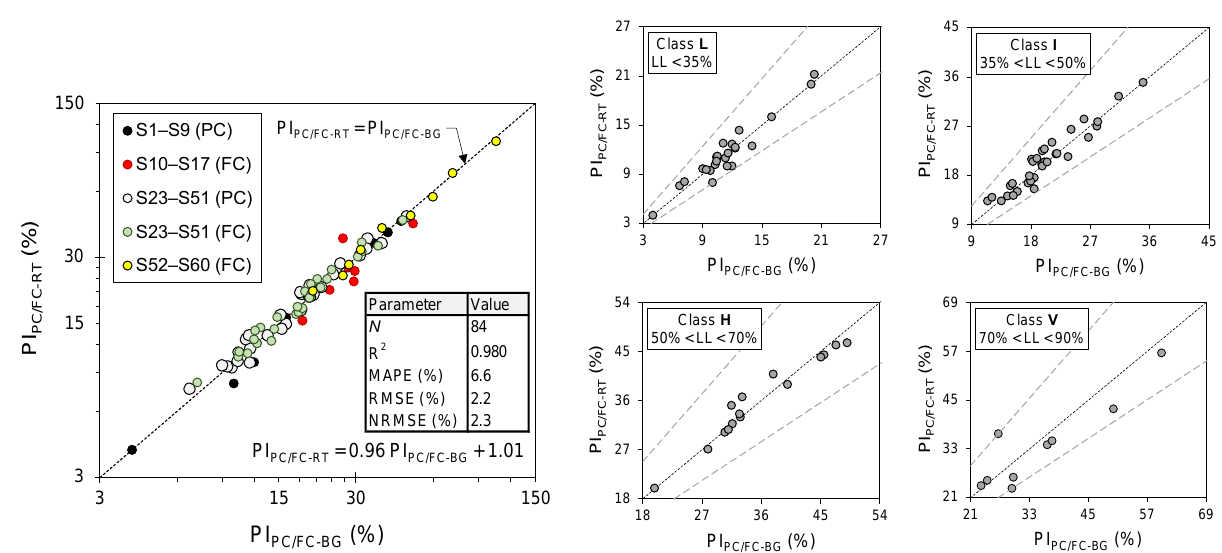
Figure 5. Variations of the RT-deduced PI (PI PC/FC-RT ) against the BG-deduced PI (PI PC/FC-BG ) for the compiled database (excluding S18–S22 for which the LL PC or LL FC values were nor reported). Note: L, I, H and V represent low, intermediate, high and very high plasticity level classes, respectively.